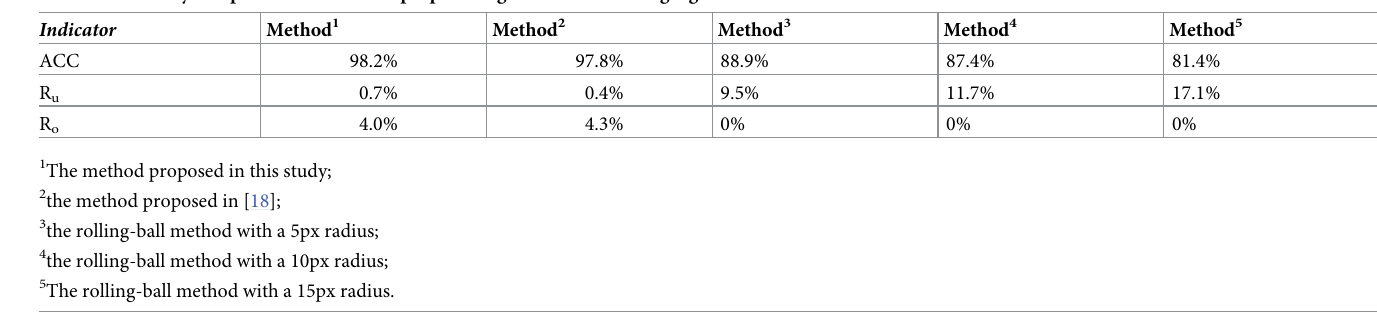
Table 1. Accuracy comparison between the proposed algorithm and existing